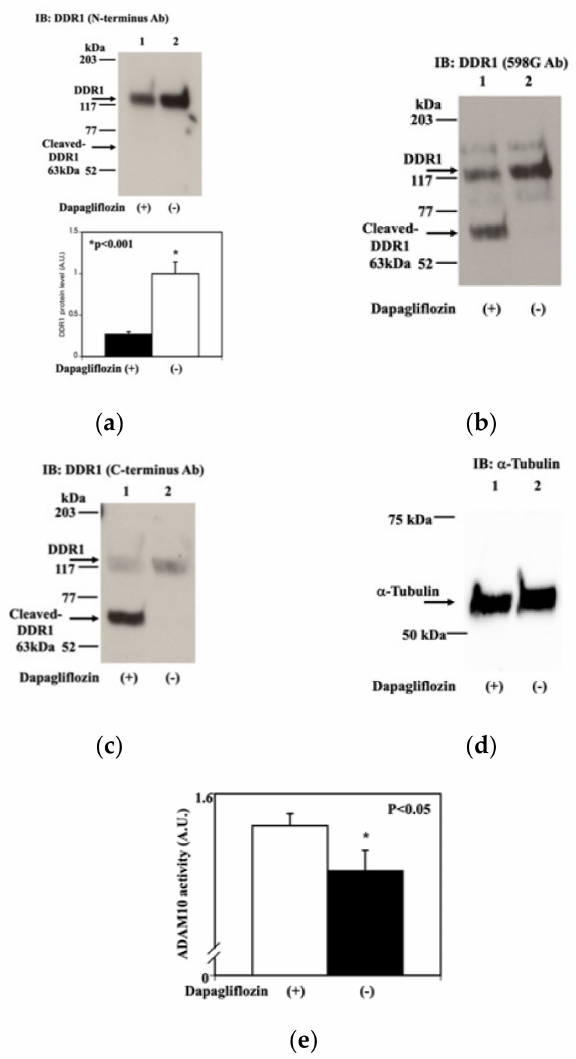
Figure 5. Dapagliflozin increases discoidin domain receptor 1 proteolytic cleavage. ( a ) E ff ect of dapagliflozin on DDR1 (N-terminus antibody). HCT116 cells were treated with either vehicle ( − ; lane 2) or 0.5 mM dapagliflozin ( + ; lane 1) for 20 min. Cell extracts were prepared and immunoblotted with an amino-terminal anti-DDR1 antibody. Only full length-DDR1 was detected. The quantification of the DRR1 protein is presented as a bar graph (n = 3, * p < 0.001). The closed column represents cells treated with 0.5 mM dapagliflozin and the open column represents DMSO-treated cells. The experiments were conducted independently in triplicate. ( b ) E ff ect of dapagliflozin on DDR1 (589G antibody). The immunoblotted membrane used in 5a was stripped and subsequently immunoblotted with 598 G antibody, which recognizes a proximal transmembrane domain epitope. Full length-DDR1 and cleaved-DDR1 showed up. ( c ) E ff ect of dapagliflozin on DDR1 (C-terminus antibody). The immunoblotted membrane used in Figure 5a,b was stripped and immunoblotted with a carboxy-terminal anti-DDR1 antibody. Full length-DDR1 and cleaved-DDR1 showed up as Figure 5b. ( d ) Estimation of loading amount. The immunoblotted membrane used in 5a–c was stripped and immunoblotted with anti-alpha-tubulin antibody. ( e ) Estimation of sheddase activity with or without dapagliflozin. Proteolytic activity was determined as described in the Experimental procedures section (n = 3, * p < 0.05). In brief, specific substrate, and dapagliflozin were mixed with the bu ff er and incubated for 60 min at room temperature. The resulting fluorescence was measured at 520 nM. Open column represents that the proteolytic activity was measured with 0.5 mM dapagliflozin and closed column represents that the proteolytic activity was measured with